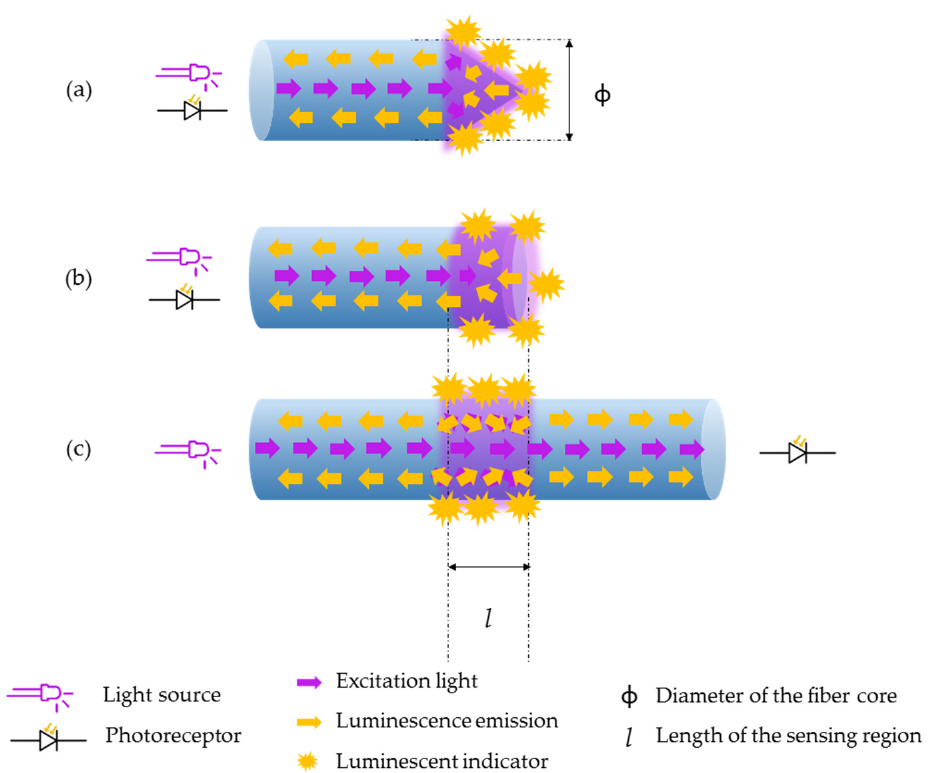
Figure 7. Different sensing schemes to fabricate luminescence-based optical fiber biosensors. ( a ) An optical fiber with a tapered tip increases its sensing surface gently (reflection architecture). ( b ) A perpendicular cut on the tip of an optical fiber is also used for biosensing using a reflection architecture. ( c ) In the transmission architecture, the sensing region is located along the fiber